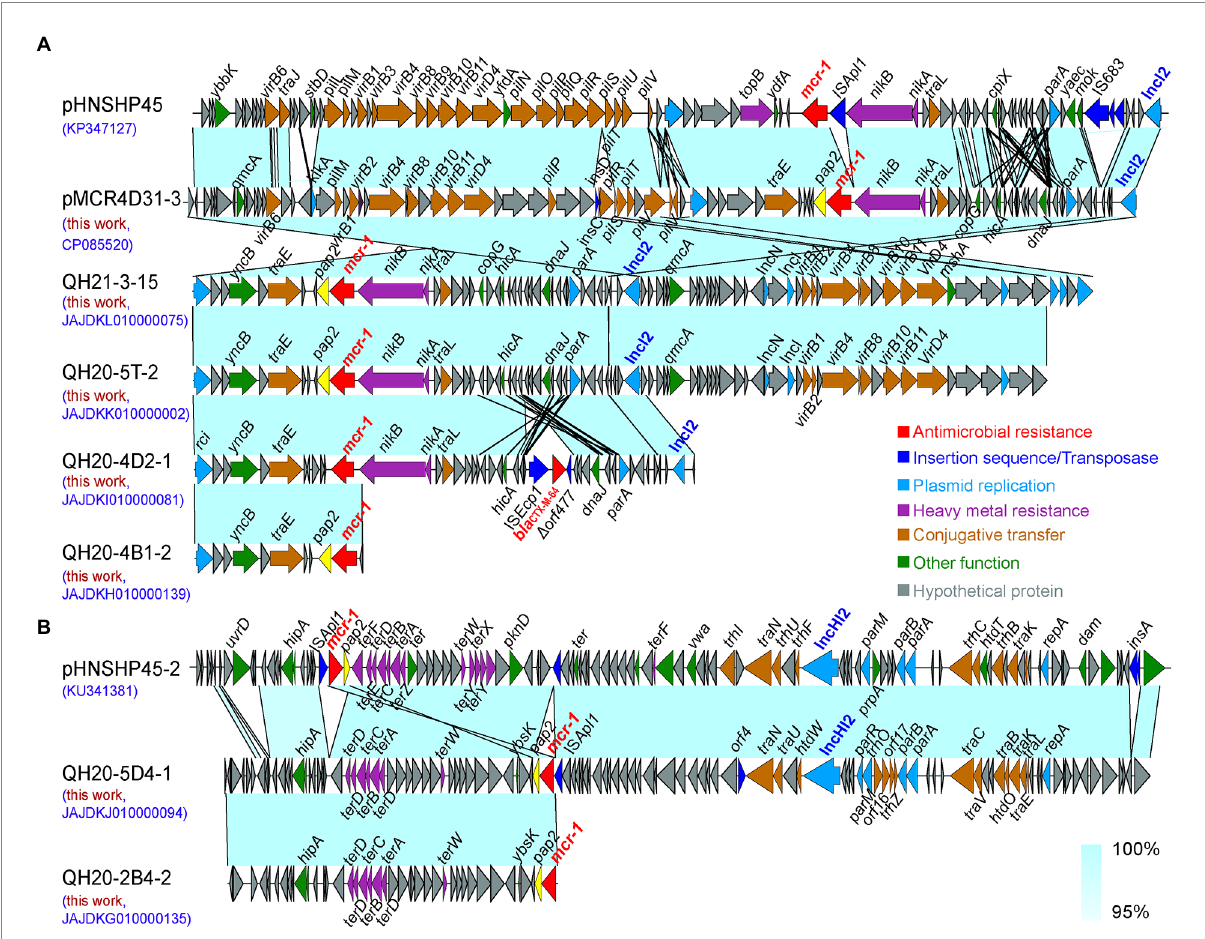
FIGURE 5 Sequence alignment analysis of IncI2 (A) and IncHI2-type (B) plasmids carrying the mcr -1 gene. The arrows indicate the direction of gene transcription. Functional genes are shown in different colors. Regions of >95% nucleotide homology are indicated by colored